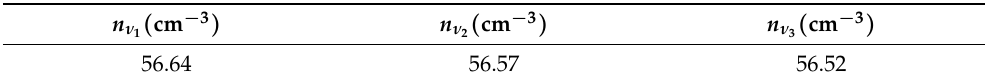
= 0 in the lightest